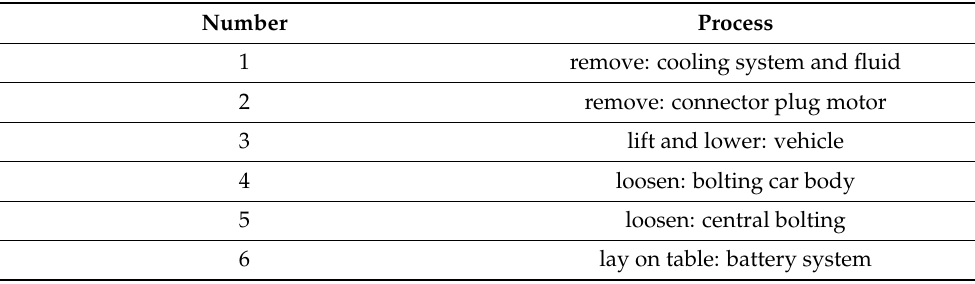
Table A4. Activities of the main processes “classification” and “disassembly”: removal of battery pack.